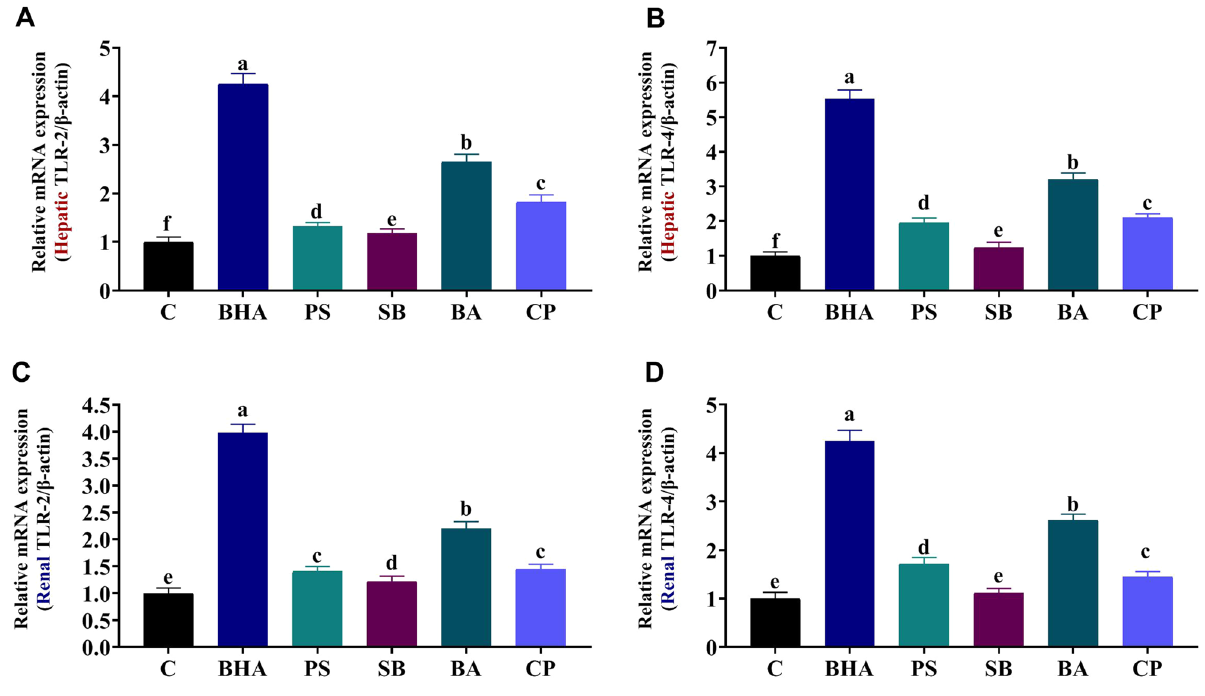
Figure 1. Expression of toll-like receptors 2 (TLR2) and toll-like receptors 4 (TLR4) in the hepatic and renal tissues of butylated hydroxyanisole (BHA), potassium sorbate (PS), sodium benzoate (SB), boric acid (BA), or calcium propionate (CP)-treated rats. β-Actin was used as the internal control. Data are expressed as the mean ± SE (n = 3 replicates). Columns with different superscripts are significantly different (one-way ANOVA, p <